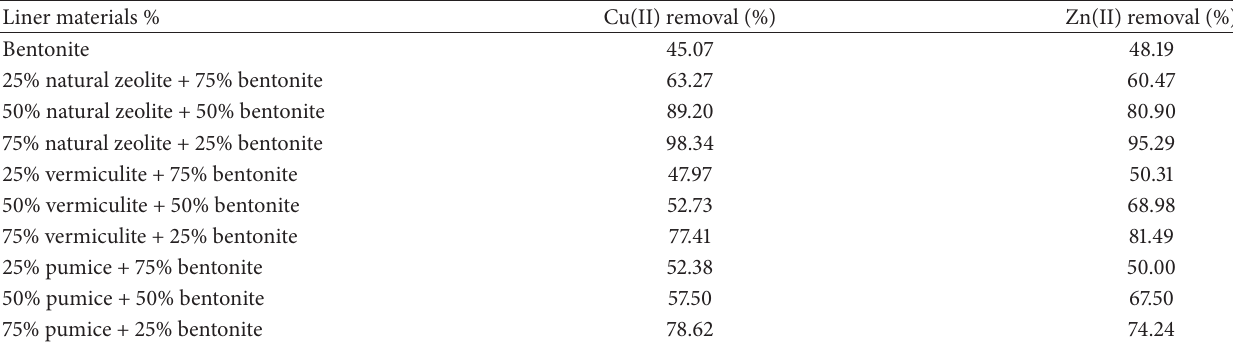
Figure 1: Proposed ANN structure for modeling adsorption system. Table 2: The whole experimental system.